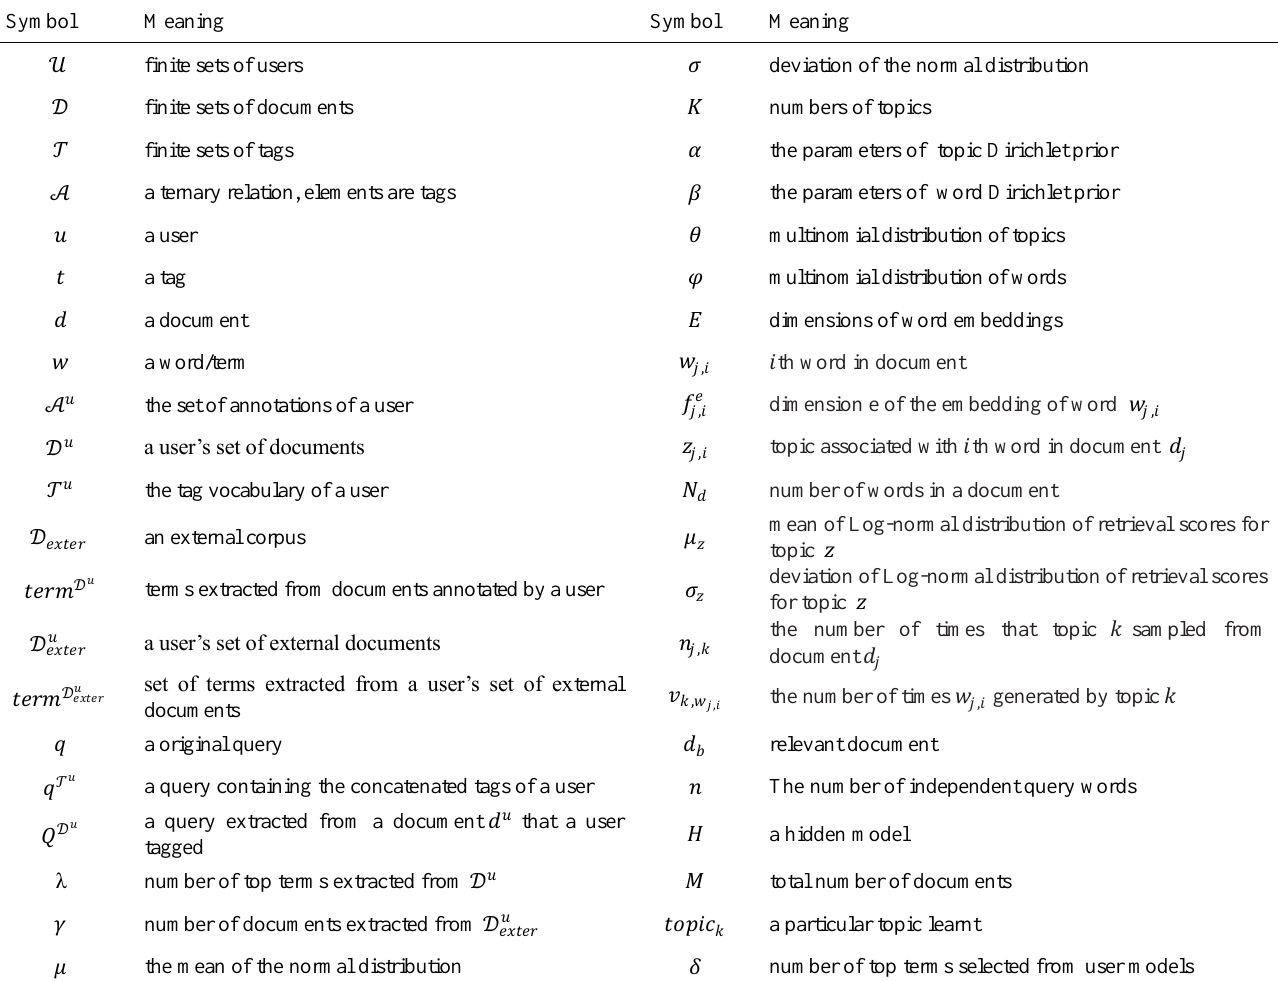
Table 1 . Basic notations used in the